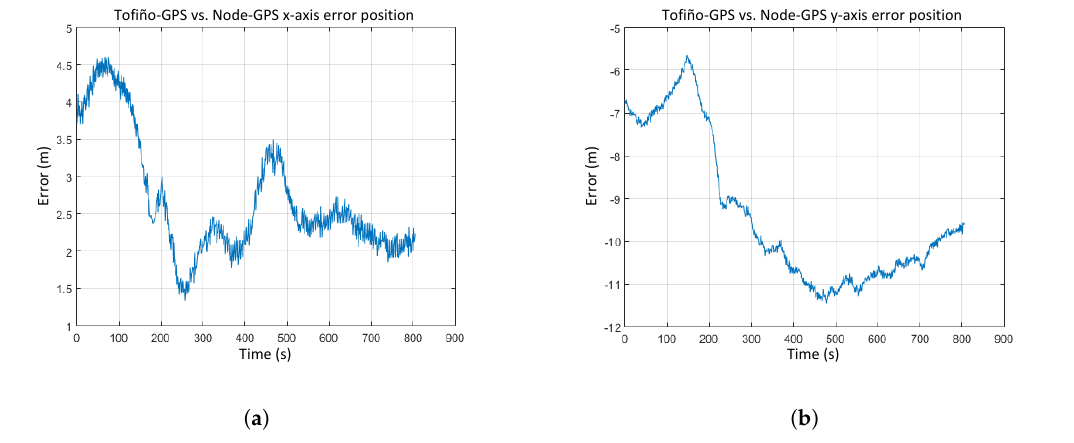
Figure 23. Error on position determination: ( a ) x axis. ( b ) y